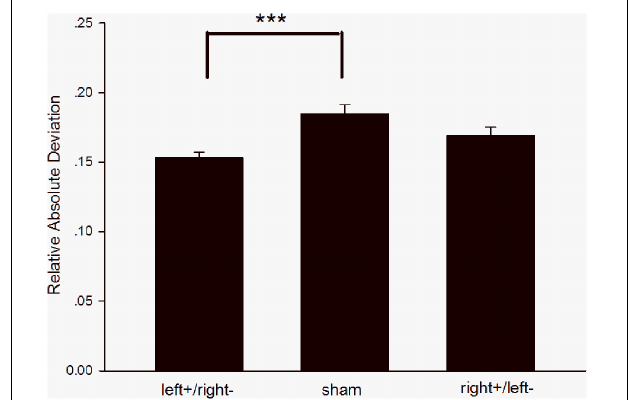
FIGURE 3 | Relative absolute deviation in different groups. The RAD of the left+/right– group was significantly smaller than that of the sham group, while there was no significant difference between the right+/left– group and the sham group. ∗∗∗ p < 0.001, Error bars indicated 95% confidence intervals.